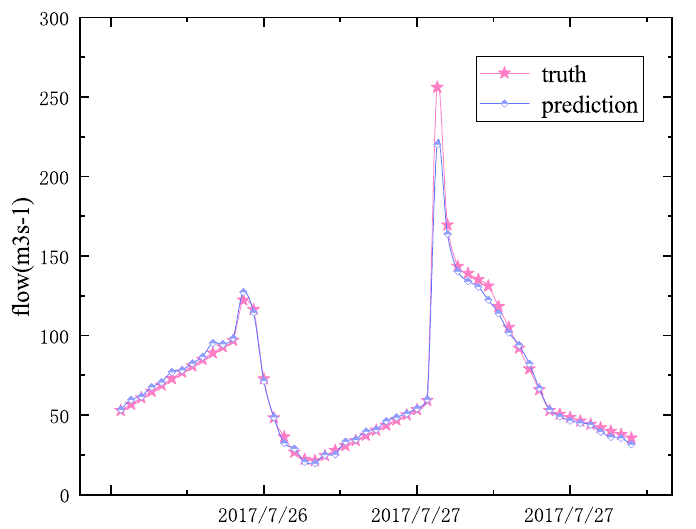
Figure 7. No. 20170727 MSBP model prediction. Pink is the true value, and blue is the predicted